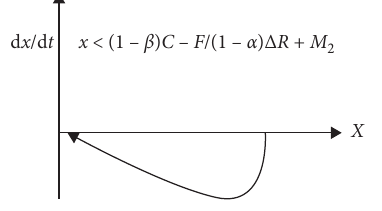
Figure 6: Stable solution for x < ((( 1 − β ) C − F ) / (( 1 − α ) Δ R + )) . M )) . 2 1